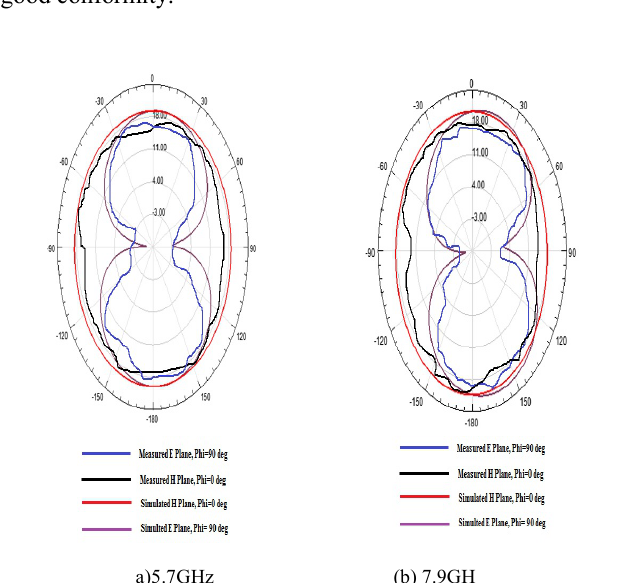
Figure 10 Simulated and measured E field radiation patterens at (a)5.7GHz and (b)7.9 GHz